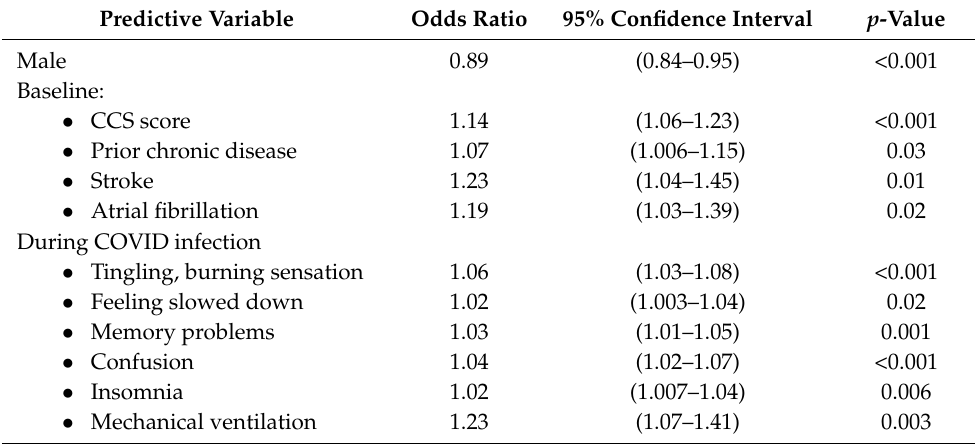
Table 6. Predictive model for Long COVID. All variables significantly associated with “Long COVID” cluster membership in the univariable analysis ( p < 0.10) were included in the multivariable prediction model. Stepwise regression was performed with backward selection of the variables retained in the model according to the Akaike